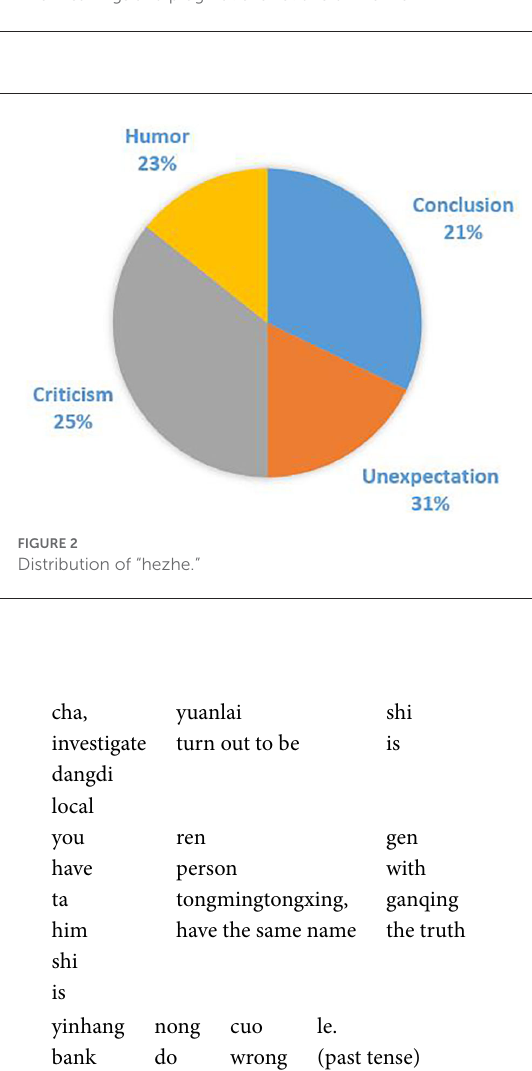
FIGURE1 The meanings and pragmatic functions of “hezhe.”